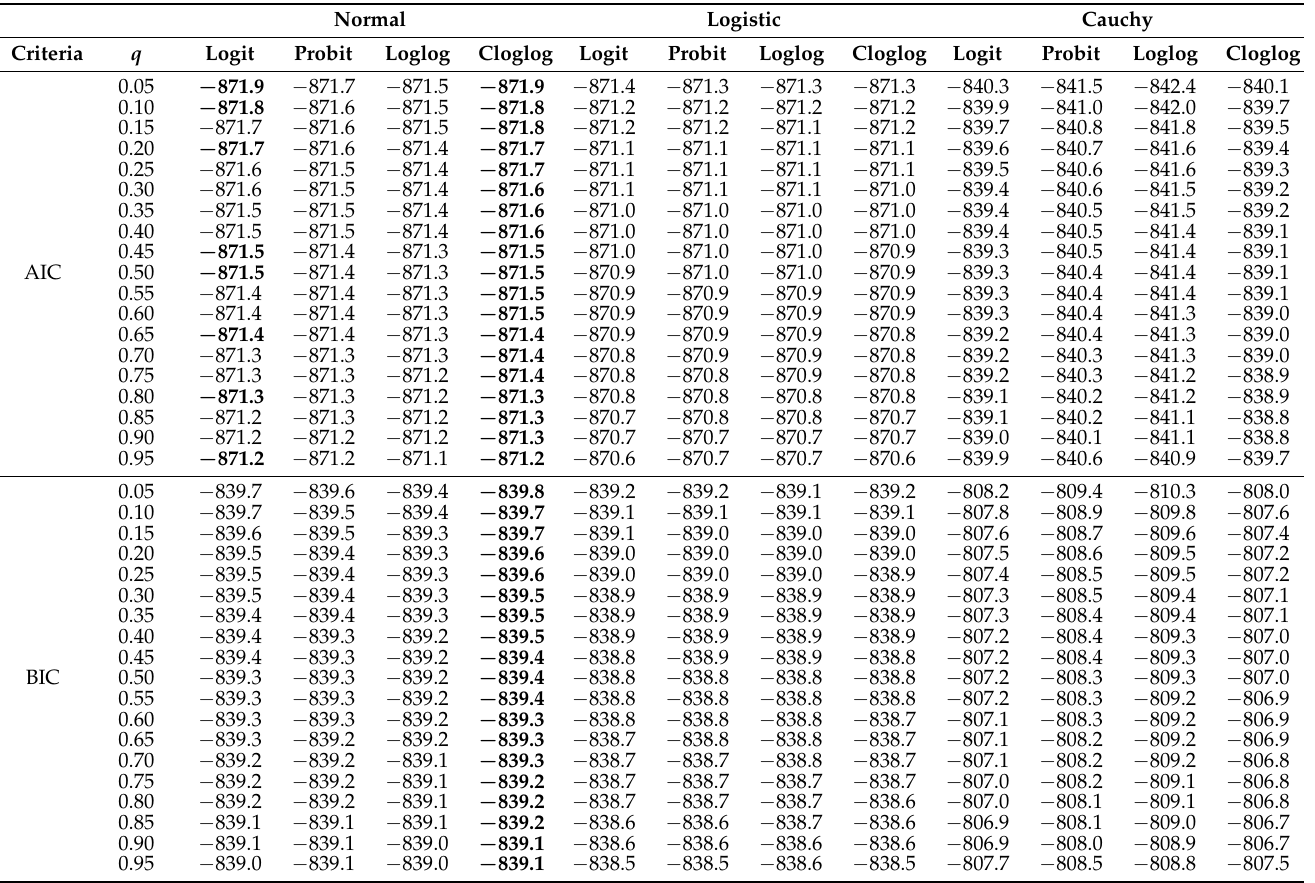
Table A1. AIC and BIC criteria for the RPGJSB1 q model of the COVID-19 data set considering